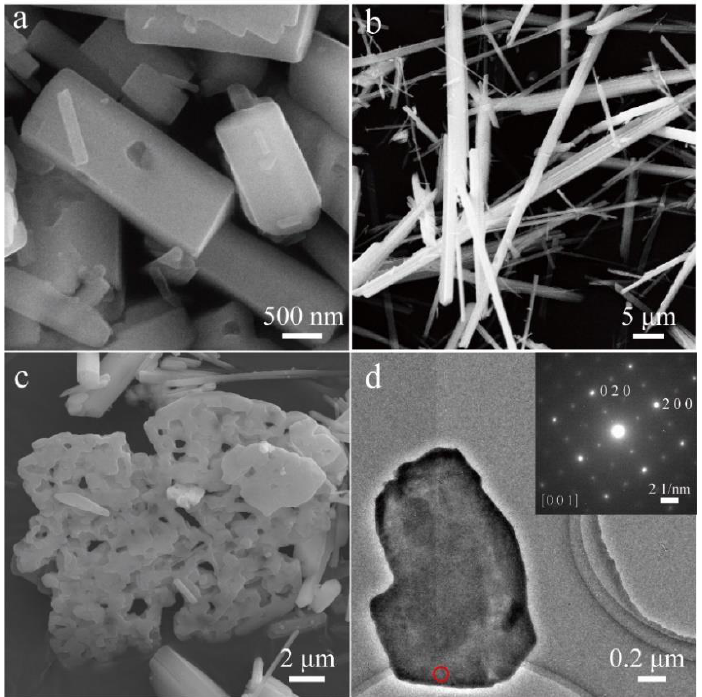
Figure 8. Microstructure of ( a ) [FeSe 2 ] 2 [Fe(dien) 2 ] hybrid particles, ( b ) (Fe 2 Se 3 ) 2 [Fe(dien) 2 ] 0.9 hybrid rods, ( c ) an intermediate product between the rodlike and the platelike samples and ( d ) a (Fe 3.5 Se 4 )-dien hybrid plate. Inset shows the corresponding SAED pattern obtained perpendicular to the nanoplate marked by the red circle.